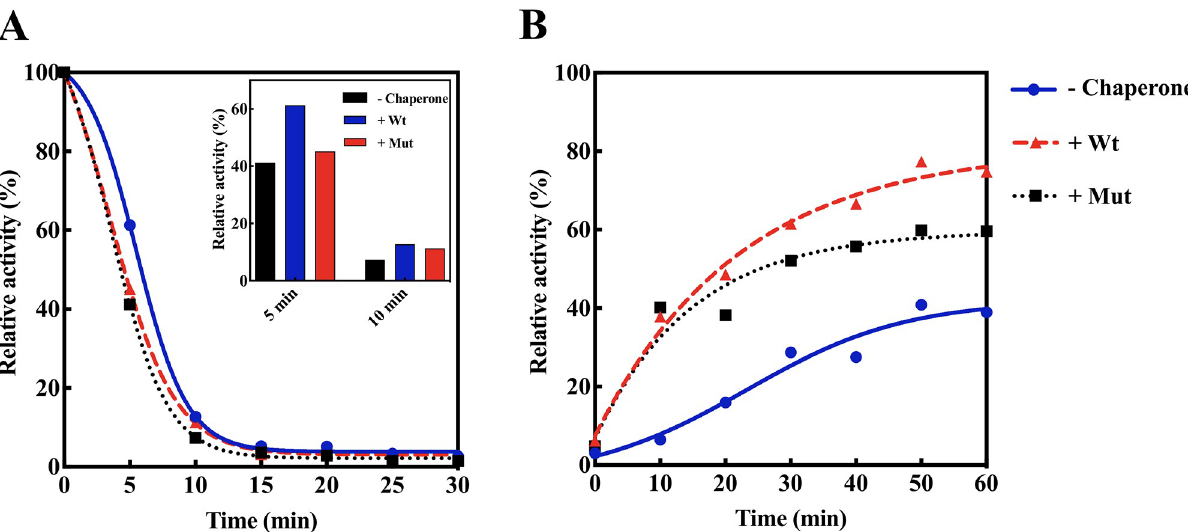
Fig 6. Restoring enzyme activity and refolding ability of different α B-crystallin samples against thermal and urea induced denaturation of α -Gls. A ) The enzyme activity of α -Gls at 45 ˚C in the presence and absence of wild-type and D109A α B-crystallins. Thermal unfolding and inactivation of α - Gls was assessed by measuring the α -Gls activity for 30 minutes with 5 minutes interval. The inset histogram shows the relative enzyme activity at 5 and 10 minutes. B ) The refolding of α -Gls occurred after its incubation in the refolding buffer (containing urea 8 M) at 25 ˚C in the presence and absence of the chaperones. The enzyme activity was measured for 60 minutes with a 10-minute interval between each